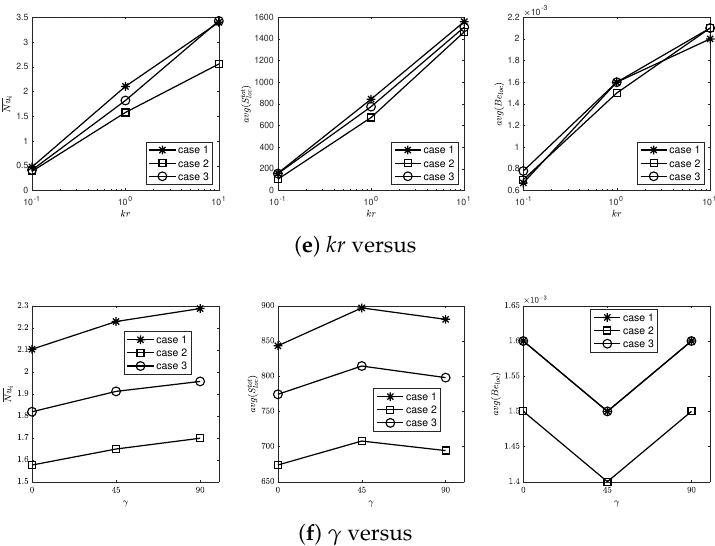
) , avg ( Be ) graphs in different loc loc